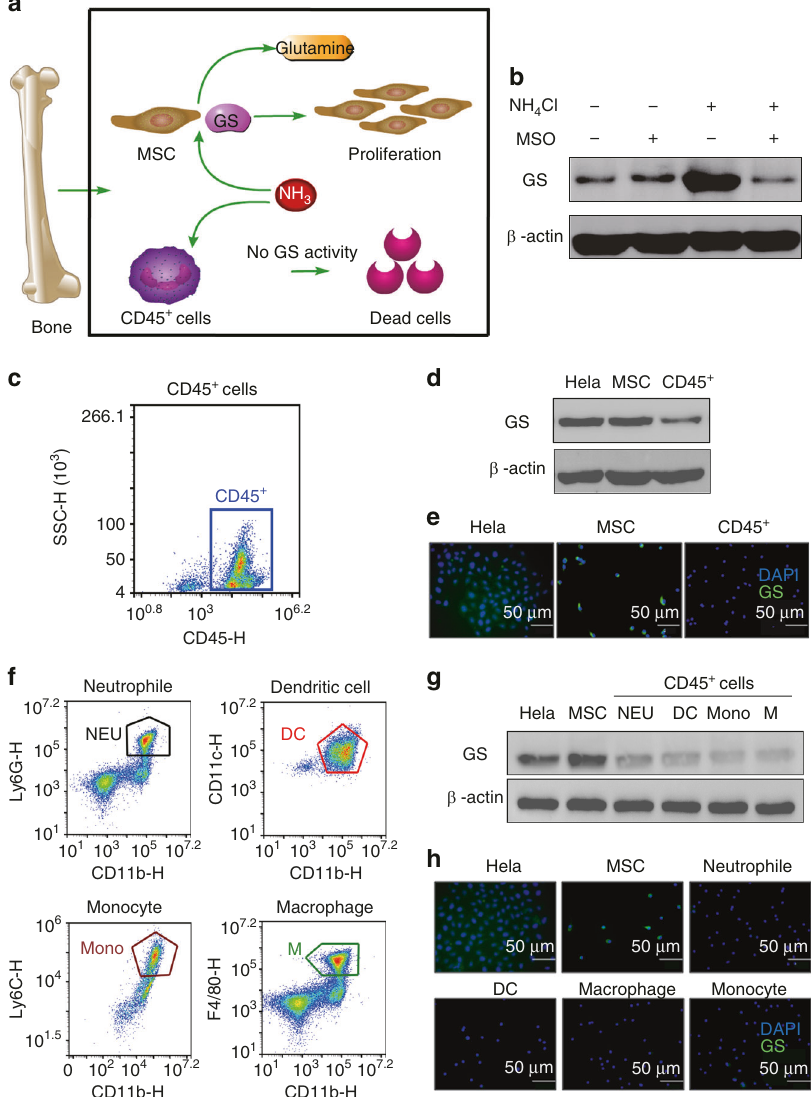
Fig. 5 The different effects of ammonia on GS-expressing cells and cells with no expression of GS in bone marrow. a Schematic of the fates of ammonia in the GS-expressing cells or non-GS-expressing cells in bone marrow. b The expression of GS in MSCs with or without both NH 4 Cl treatment and MSO treatment via western blots. c CD45 + cells from mouse bone marrow sorted by fl ow cytometry. d The expression of GS analysis between MSCs and CD45 + cells via western blots, with HeLa cells as a positive control. e The expression of GS in MSCs and CD45 + cells via immuno fl uorescence, with HeLa cells as a positive control. f CD45 + cells, including neutrophils ( CD45 + CD11b + Ly6G + ) , DCs (CD45 + CD11b + CD11c + ) , monocytes (CD45 + CD11b + Ly6C + ) and macrophages (CD45 + CD11b + F4/80 + ) , were sorted by fl ow cytometry. g The expression of GS in MSCs, neutrophils, DCs, monocytes and macrophages via western blots, with HeLa cells as a positive control. h The expression of GS in MSCs, neutrophils, DCs, monocytes and macrophages via immuno fl uorescence. HeLa cells were used